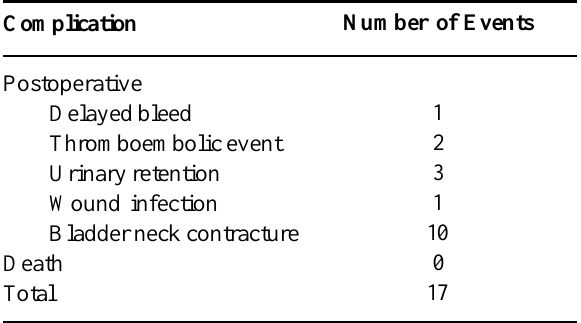
Table 2 – Perioperative